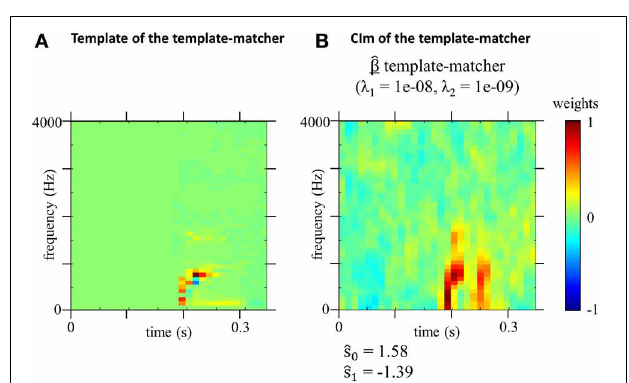
FIGURE 5 | (A) Difference template w used by the template matcher (difference between spectrograms of the targets). (B) Estimated model parameters for the template-matcher optimal hyperparameters λ 1 and λ 2 ( n = 10000 trials). Weights are divided by their maximum absolute values.